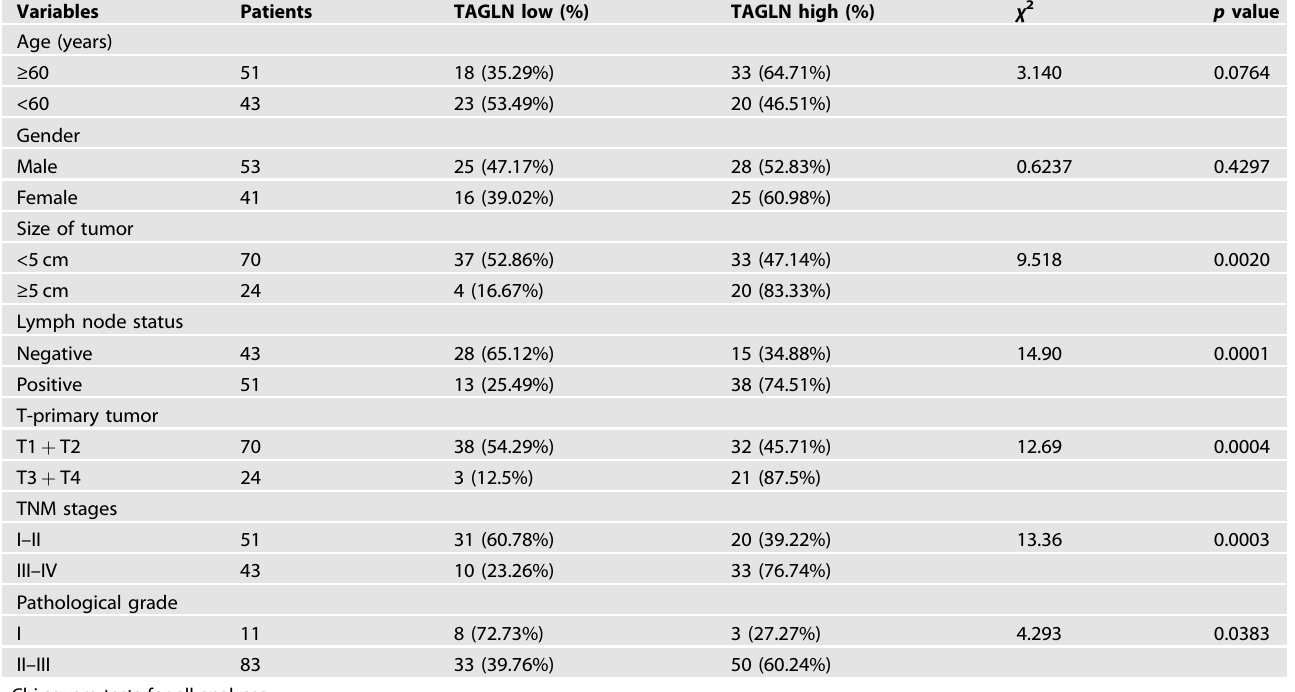
Table 1. Clinicopathological variables of patient samples and expression of transgelin in lung cancer stroma.